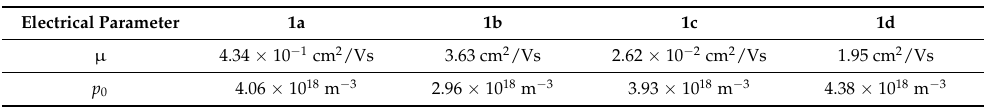
Table 6. Electrical parameters under natural illumination for ITO/PEDOT:PSS-graphene- organotin(IV) complex/Ag devices under daylight